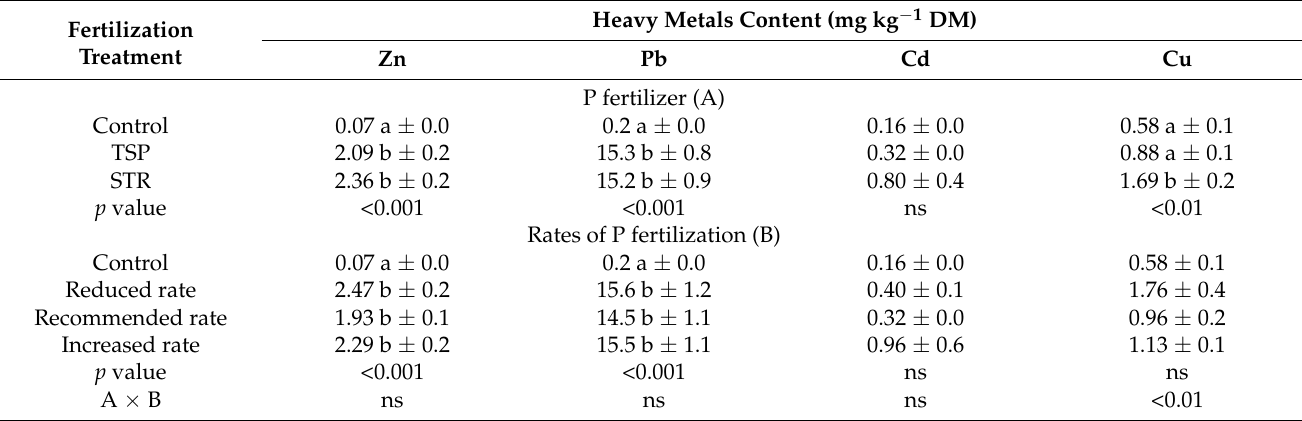
Table 6. Effect of P fertilization on selected heavy metal contents in the peat substrate. Fertilization